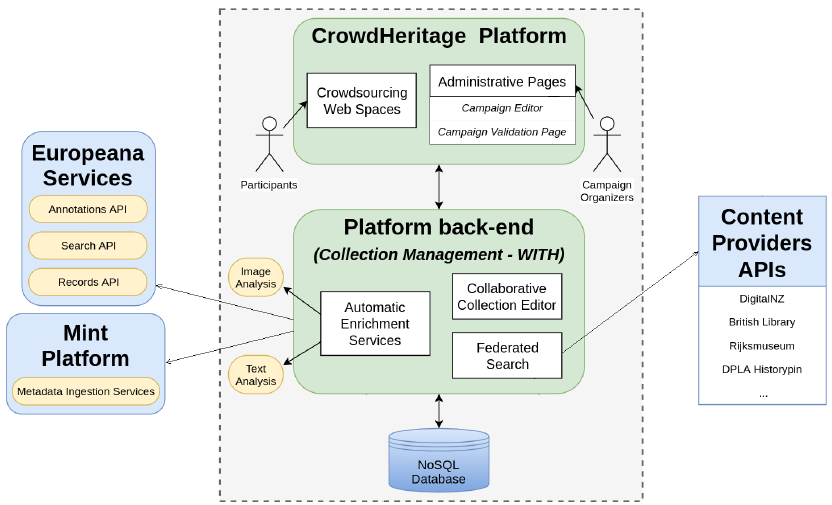
Figure 2. CrowdHeritage platform